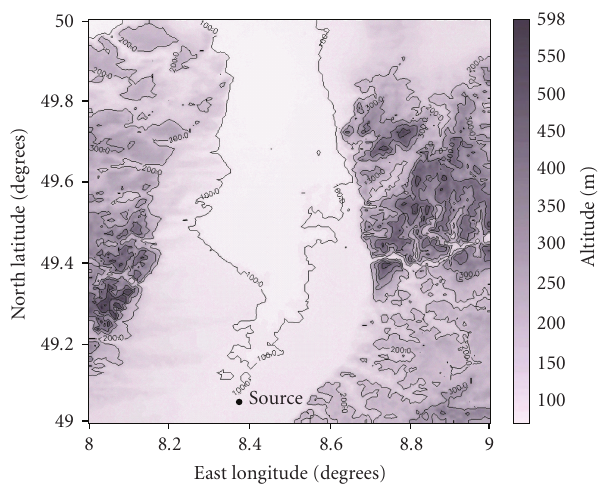
Figure 1: Topography of the domain and source locations.